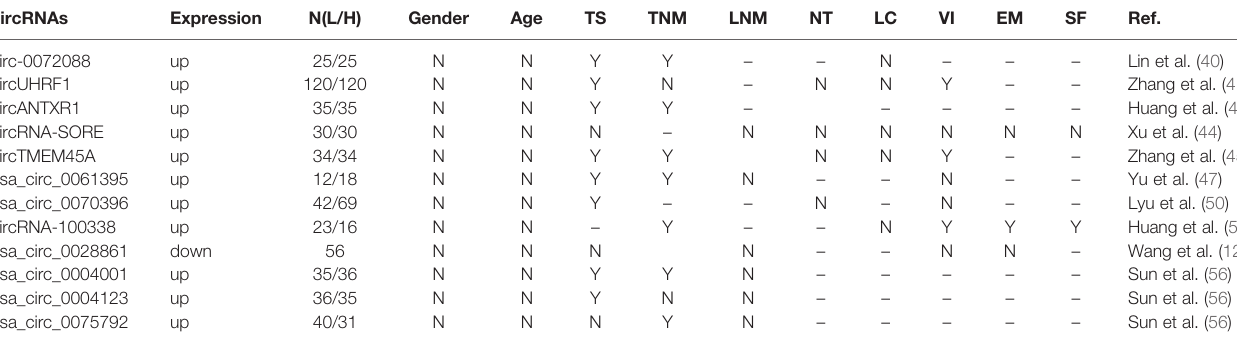
TABLE 2 | Relationship between exosomal circRNAs and clinicopathologic characteristics in HCC.